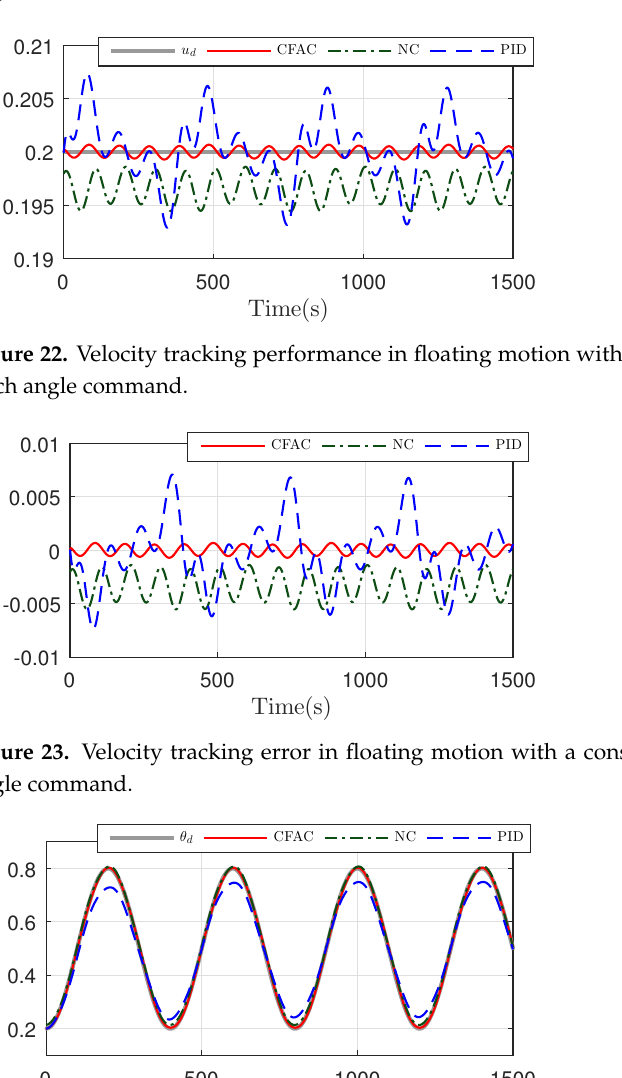
Figure 21. Control input U 2 in floating motion with a variable velocity and constant pitch angle command.